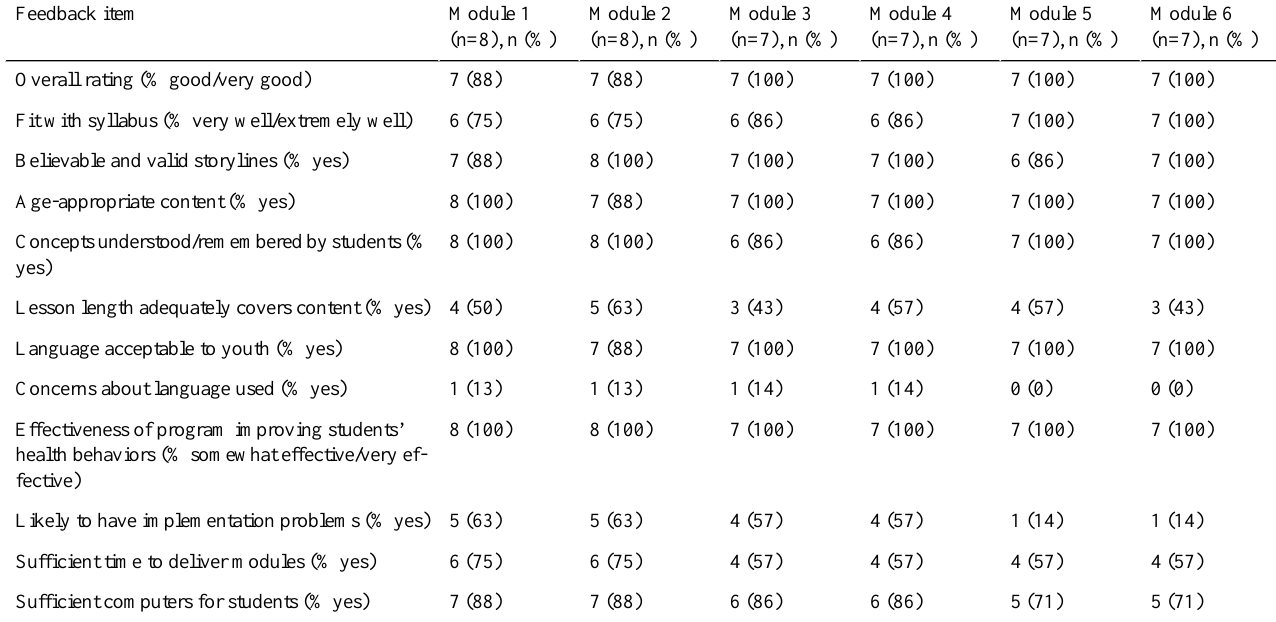
Table 6. Summary of teacher questionnaire